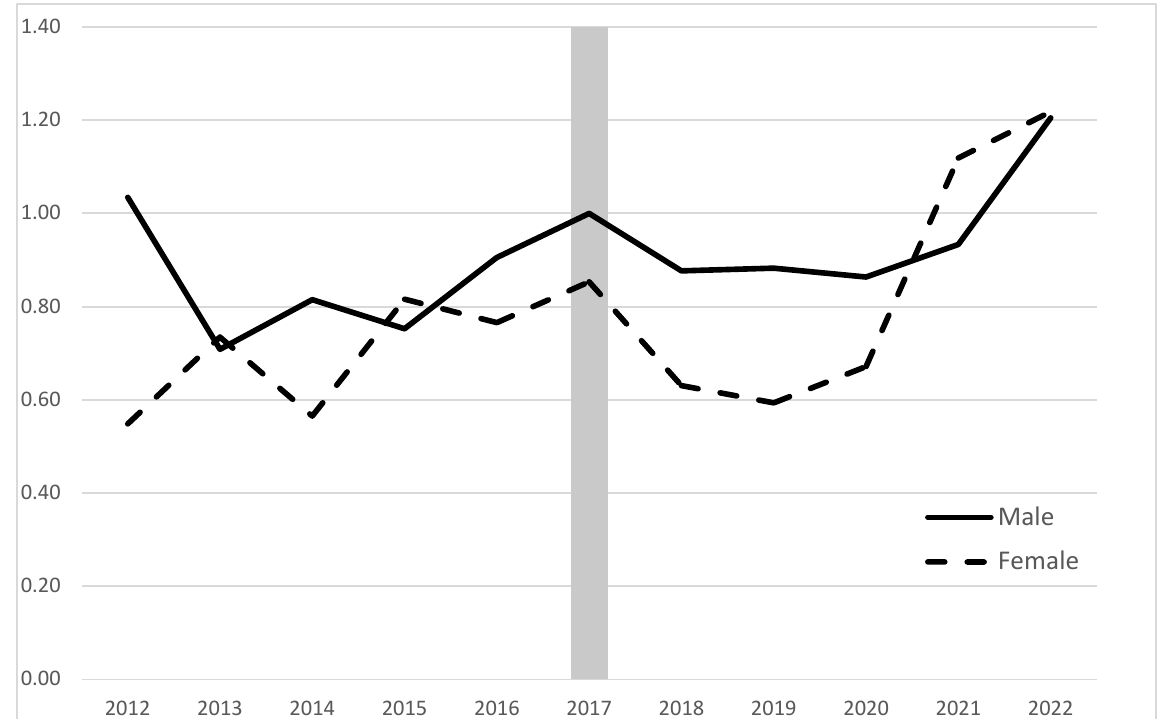
Figure 1. Scaled male and female ≥ 18 urethroplasty-to-endoscopic management ratio, adjusted for HCO number.